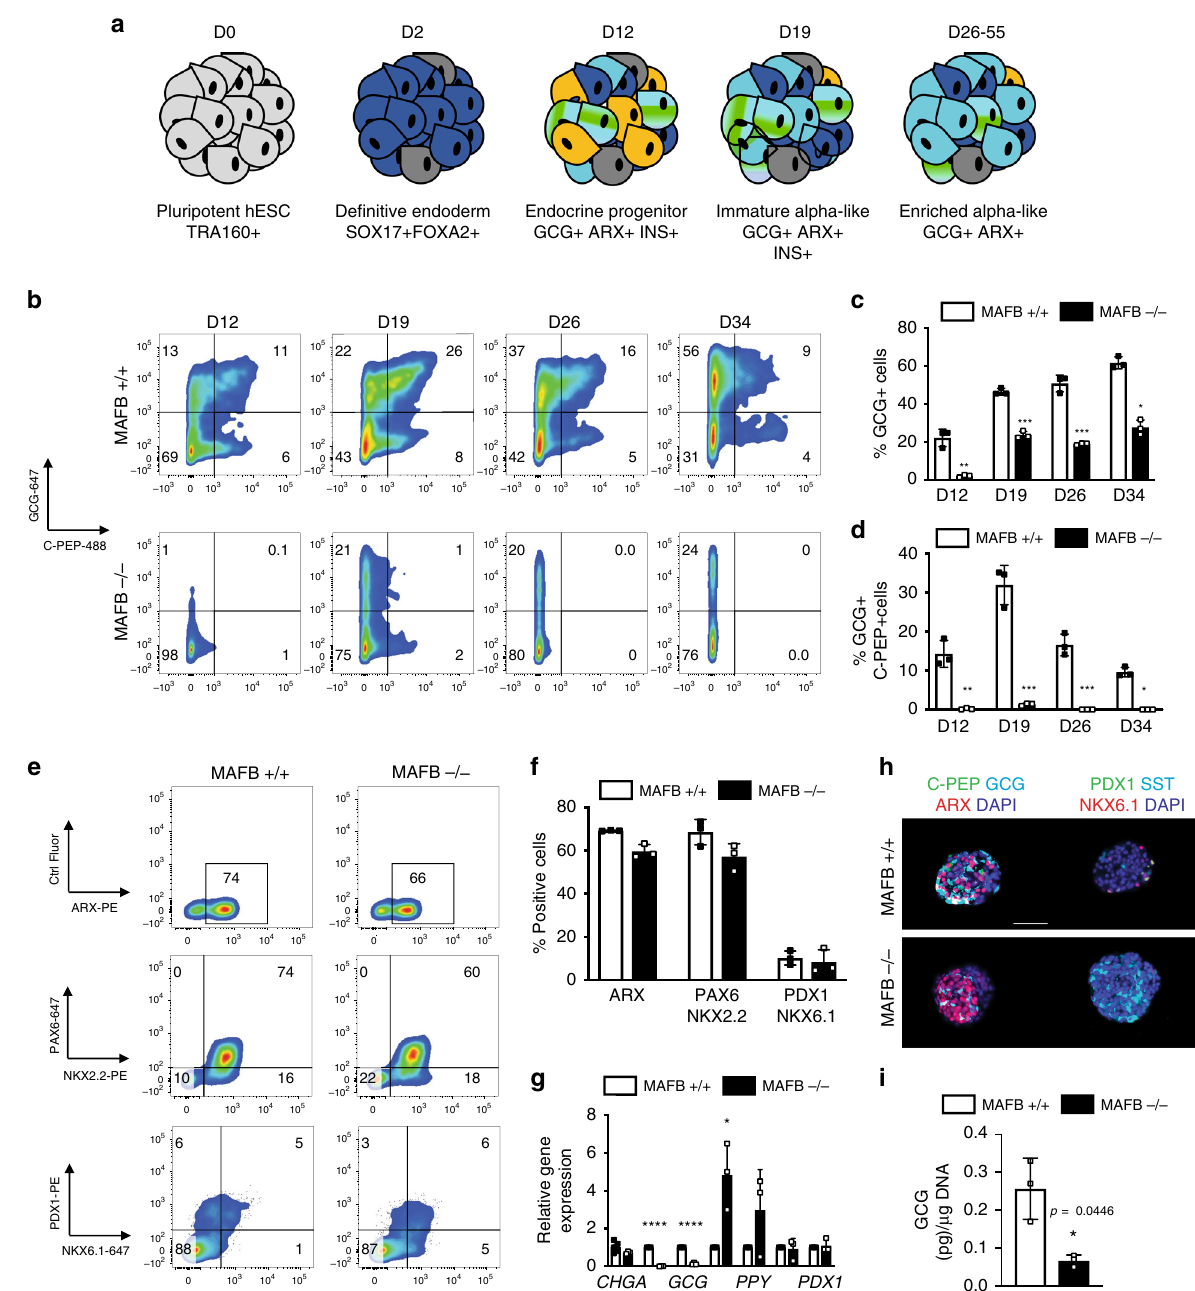
Fig. 6 Loss of MAFB limits α -cell differentiation. a Schematic outlining the differentiation protocol to generate α -like cells from hESCs. The key lineage markers are outlined at each stage. Chemicals and durations for each differentiation stage are indicated in the Methods section. d, day(s); hESC, undifferentiated hESC stage; DE, de fi nitive endoderm stage (SOX17 + FOXA2 + ); EP, endocrine progenitor (CHGA + PDX1 + ); immature α -like cells (GCG + INS + ARX + ) and enriched α -like cells (GCG + ARX + ). b Representative FC plots at the indicated time point depicting the percentages of GCG + C-PEP + cells and quanti fi cation at the DE stage. c , d Quanti fi cation of FC data outlined in ( b ) ( n = 3). P values by one-way ANOVA followed by Dunnett ’ s multiple comparisons test were * P < 0.05, ** P < 0.01, *** P < 0.001, **** P < 0.0001. Data are presented as individual biological replicates and represent the mean ± SD. e Representative FC plots at the α -like cell stage depicting the percentages of ARX + , PAX6 + NKX2.2 + , and PDX1 + NKX6.1 + cells. f Quanti fi cation of FC data in ( e ) ( n = 3, biologically independent samples). g The mRNA expression patterns of designated genes for islet hormones and selected transcription factors ( CHGA , INS, GCG, SST, PPY, ARX , and PDX1 ) as measured by quantitative PCR analysis ( n = 3, biologically independent samples). P values by unpaired two-tailed t -test were * P < 0.05, ** P < 0.01, *** P < 0.001, **** P < 0.0001. h Representative IF images from three independent experiments at the α -cell stage depicting GCG, INS and ARX and PDX1, SST and NKX6.1 in d26 α -cells from MAFB + / + and − / − differentiations. Scale bars, 50 μ m. i Quanti fi cation of total GCG content from MAFB + / + and − / − cells at d26 – 34 in vitro ( n = 3, biologically independent samples). P values by paired two-tailed t